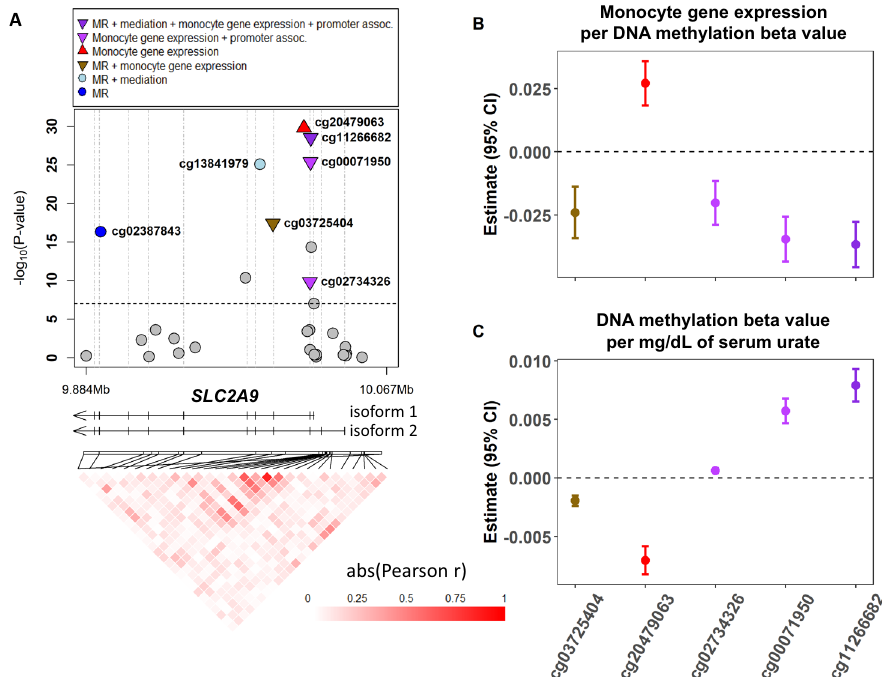
Fig. 4 Associations of CpGs at SLC2A9 with serum urate levels and gene expression in monocytes. CpGs in the SLC2A9 region ( A ) with the effect size of DNA methylation on gene expression in monocytes at fi ve replicated CpGs ( B ) and the effect size of serum urate on DNA methylation levels at these same fi ve CpGs ( C ). All labeled CpGs were replicated. In the legend, MR indicates CpGs with a signi fi cant causal effect on serum urate levels based on Mendelian randomization analysis. Colors of the estimates in panels B and C match the color legend in panel A . Promoter-associated annotation was based on the Illumina HM450K annotation fi le. The gene models were based on RefSeq curated genes. The correlations between the CpGs were generated using DNA methylation data from 804 European Americans participants of the ARIC study. The association between DNA methylation and monocyte gene expression in panel B is based on Kennedy et al. BMC Genomics 2018 ( n = 1202). The DNA methylation estimates in panel C are based on the meta- analysis combining discovery and replication cohorts in the present study ( n = 17,996). Genbank RefSeq accession numbers: isoform 1 (NM_020041), isoform 2 (NM_001001290). MR Mendelian randomization, assoc. associated.